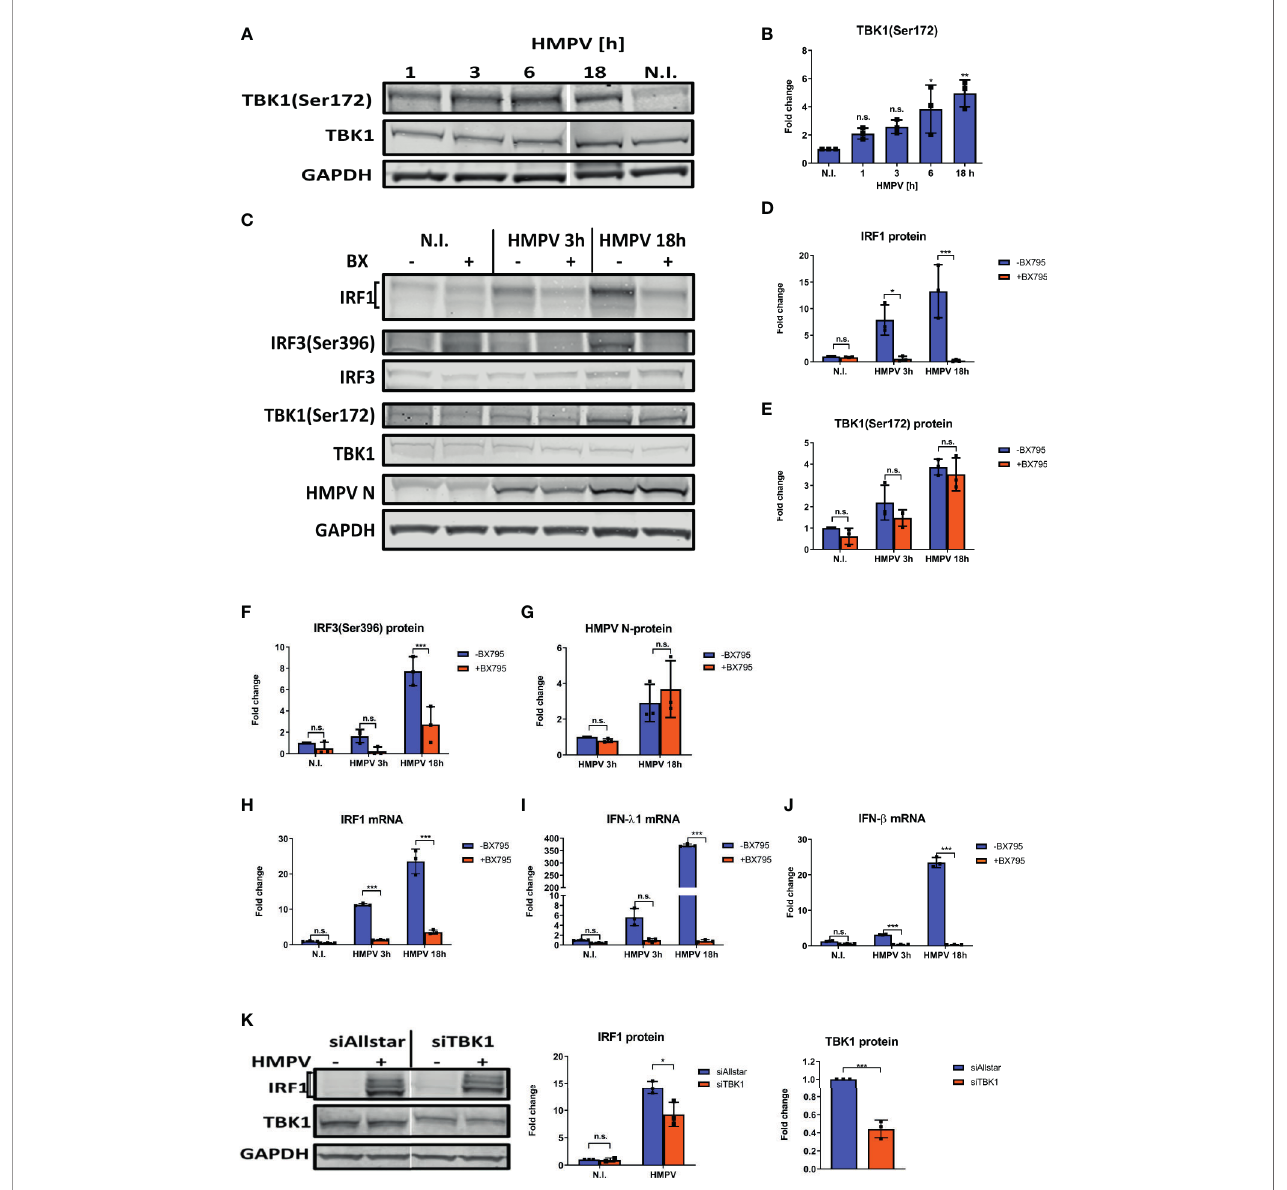
FIGURE 3 | TBK1 is required for IRF1 expression in response to HMPV. (A, B) Human MDMs were infected for the indicated timepoints with HMPV or treated with medium ( “ N.I. ” ). Whole cell lysates were prepared and protein levels of TBK1 and p-TBK1(Ser172) were analyzed by immunoblotting. Protein levels were quanti fi ed by normalization of band intensities against GAPDH and are presented as fold change relative to uninfected cells ( “ N.I. ” ) (B) . (C – J) Human MDMs were pretreated with or without BX795 before infection with HMPV for the indicated timepoints. (C – G) Whole cell lysates were prepared and protein levels of IRF1, p-TBK1(Ser172), TBK1, p-IRF3(Ser396) and IRF3 were analyzed by immunoblotting. Protein levels were quanti fi ed by normalization of band intensities against GAPDH and are presented as fold change relative to uninfected cells ( “ N.I. ” ). (H – J) MRNA expression of IRF1, IFN- l 1 and IFN- b was determined by qRT-PCR. (K) MDMs were transfected with TBK1 siRNA or control siRNA («Allstar») prior to infection with HMPV for 18 hours. Whole cell lysates were prepared and protein levels of IRF1 and TBK1 were analyzed by immunoblotting. Protein levels were quanti fi ed by normalization against siAllstar N.I. cells and GAPDH levels. Statistical analysis: Two-way ANOVA with Tukey ’ s honest signi fi cance test: ∗ p < 0.05; ∗∗ p < 0.01; ∗∗∗ p < 0.001; n.s., not signi fi